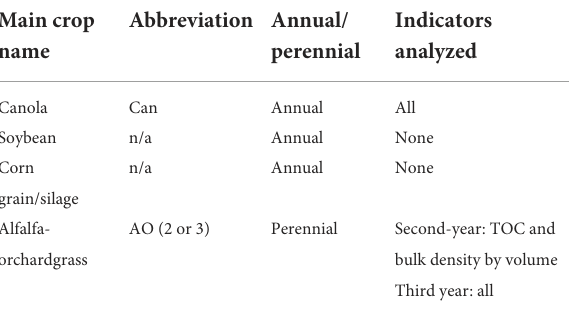
TABLE 1 The main crops in the rotation sequence, the abbreviation used within the paper, and which soil analyses was conducted in each